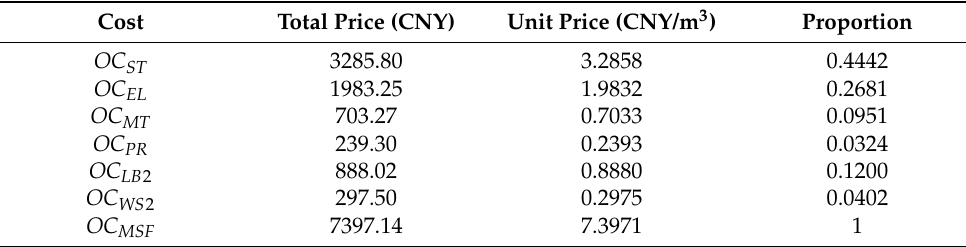
Table 9. BR-MSF system cost ratio table.